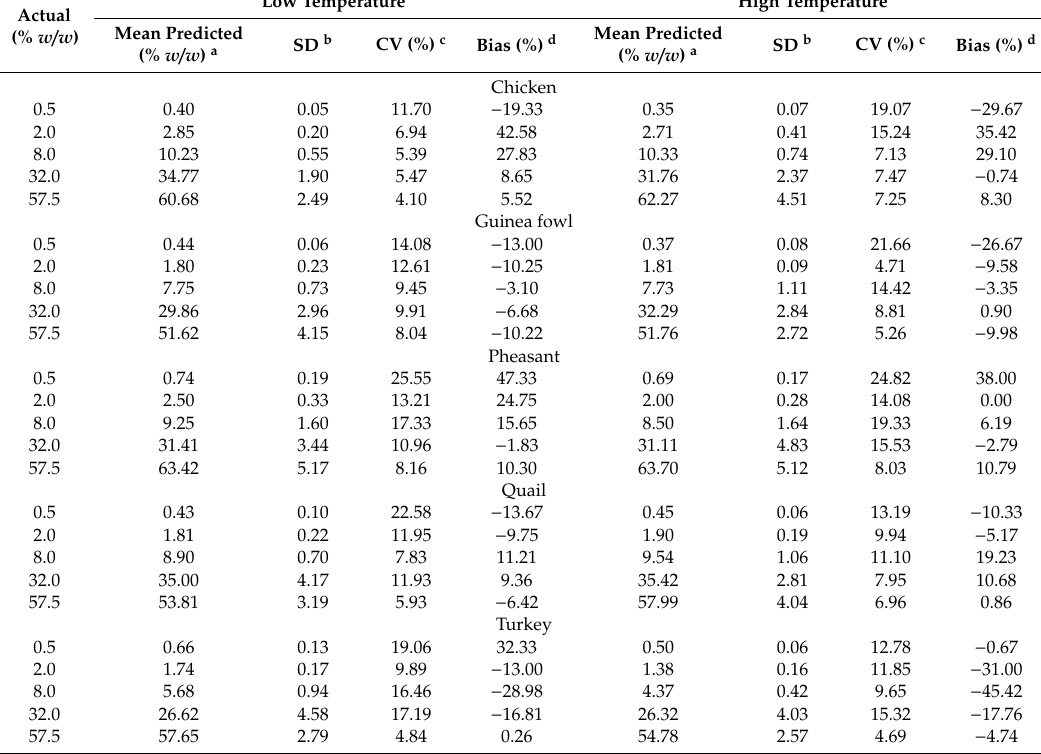
Table 6. Predicted concentrations of meat from five poultry species in unknown emulsified type sausages under two temperature conditions, quantified with matrix-specific multiplication factors. Actual (% w / w )